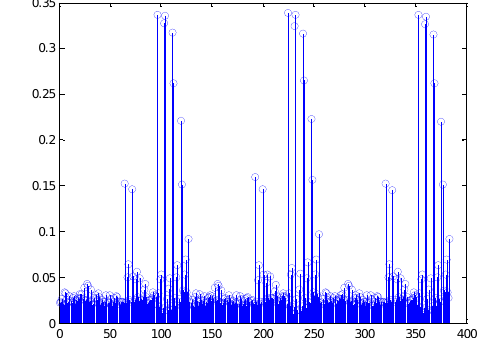
Figure 1. One of the transform color SIFT descriptor